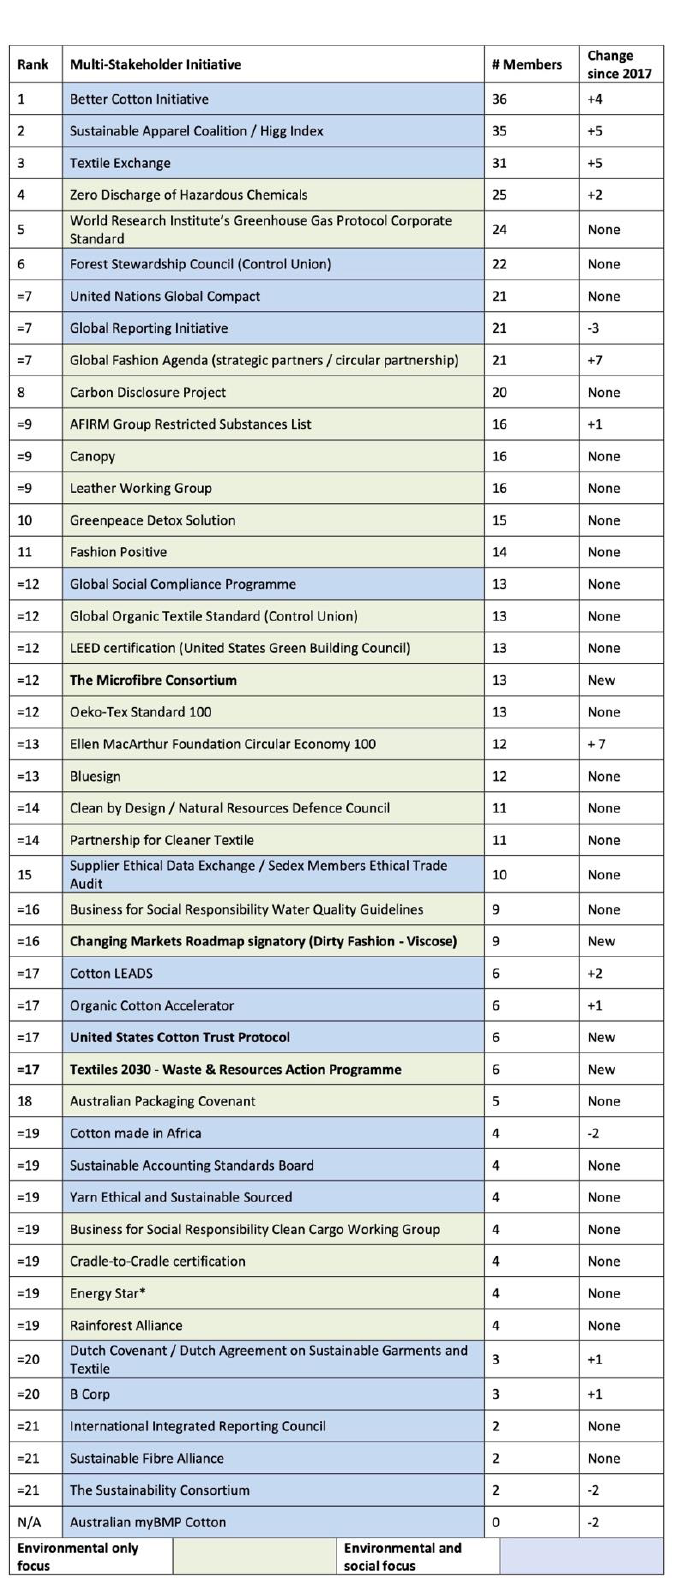
Table 3. MSIs mapped to retailer membership, 2021